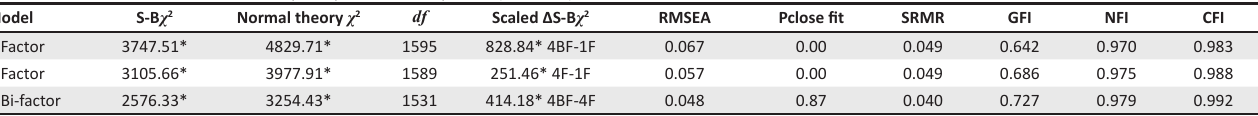
TABLE 3: Goodness-of-fit indices for the principled leadership scale (58 items) measurement models. Model S-B χ 2